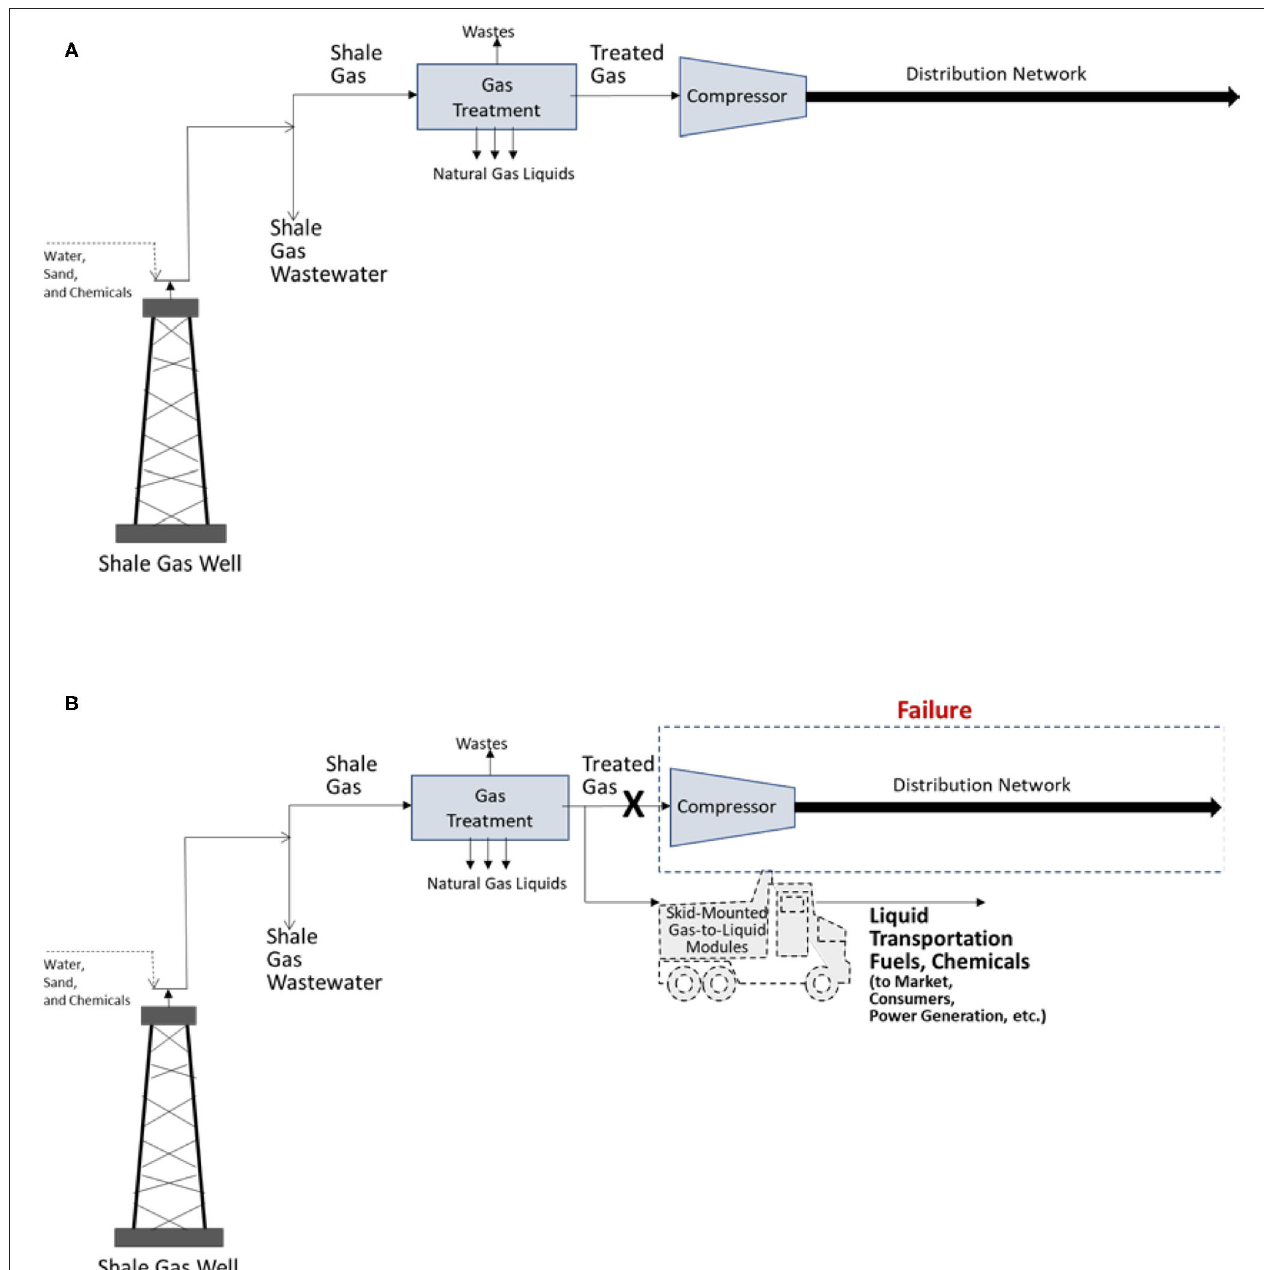
FIGURE 5 | (A) Shale gas distribution. (B) Deployment of modular GTL units for resilient shale gas